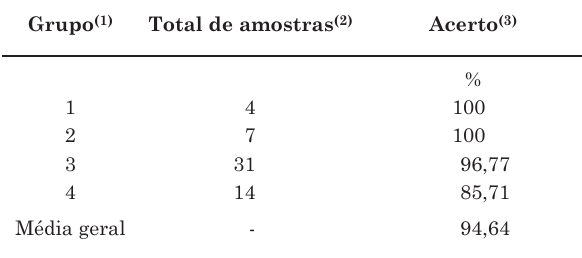
(1) Grupos obtidos pela análise de agrupamento. (2) corresponde ao número de amostras de solos que compõem cada grupo previamente definido pela análise de agrupamento. (3) Percentual de acerto das amostras classificadas em cada grupo, segundo a análise